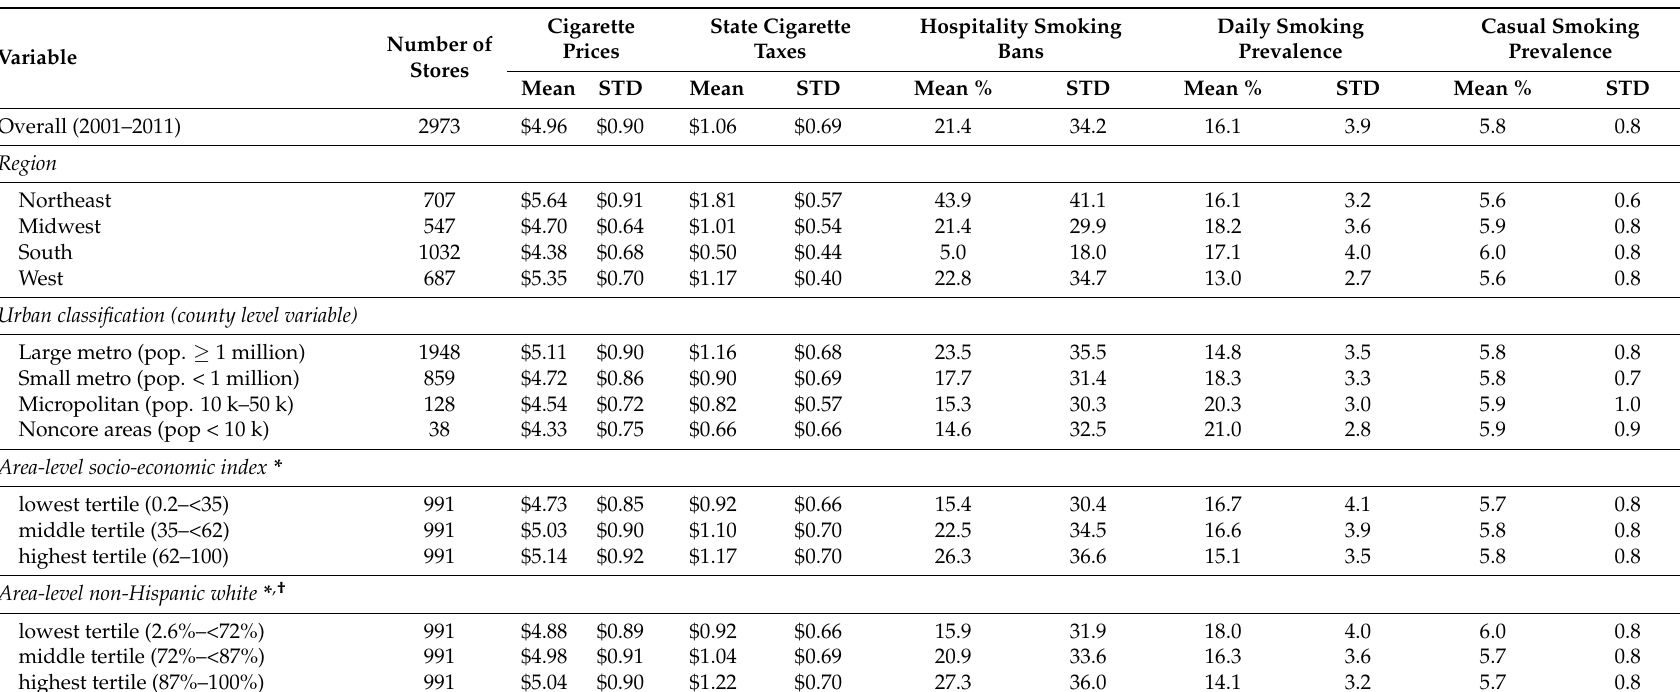
Table 1. Characteristics of stores in the dataset: cigarette prices (per pack), taxes (per pack), hospitality bans, and smoking prevalence by region, urbanicity, and area-level socio-demographic